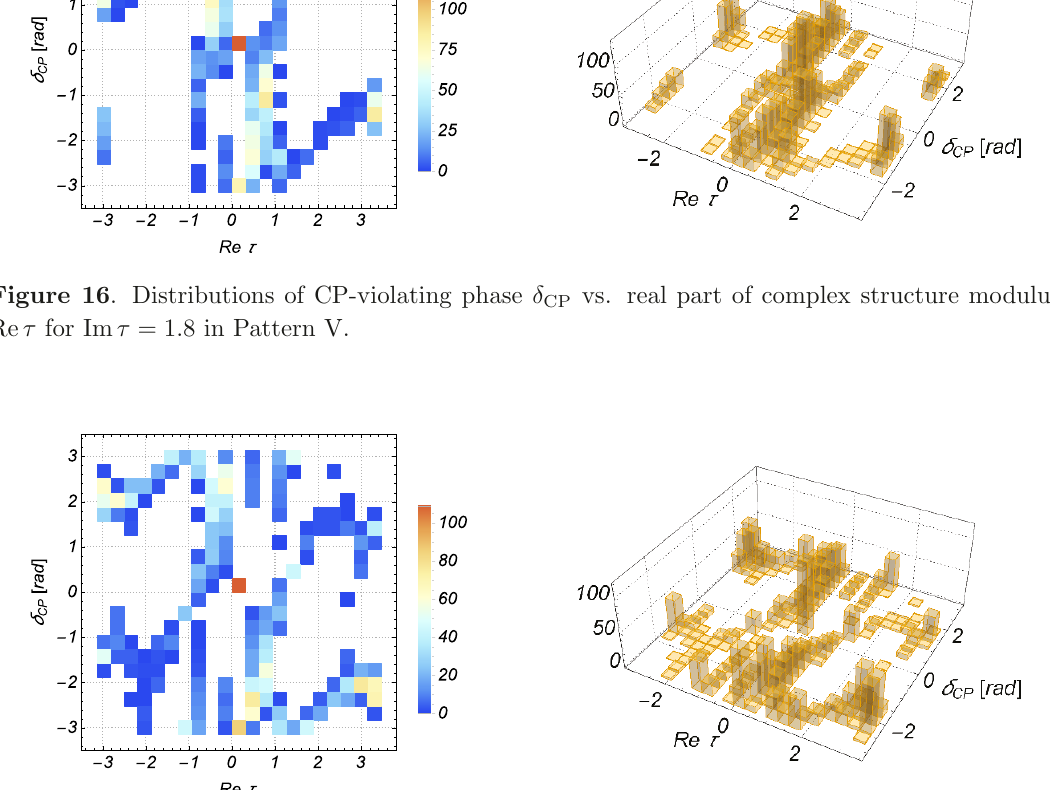
Figure 17 . Distributions of CP-violating phase δ CP vs. real part of complex structure modulus Re τ for Im τ = 2 . 0 in Pattern V.